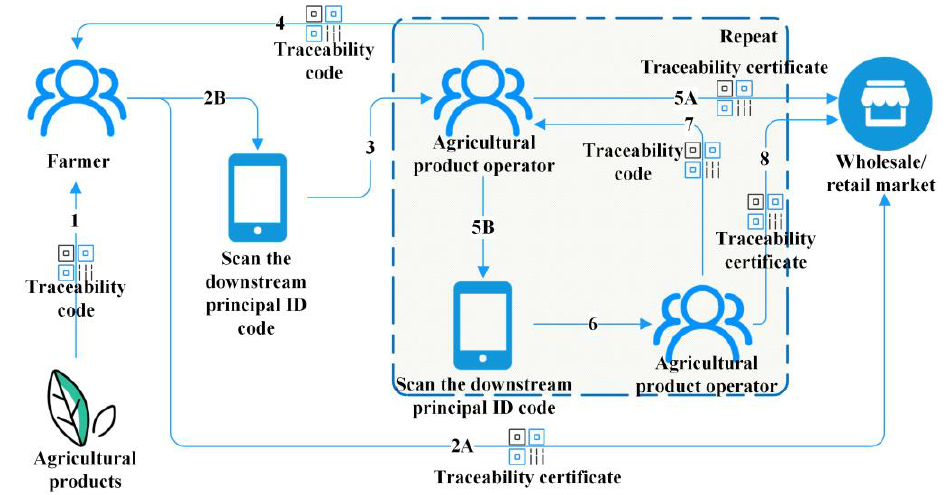
Figure 1. The flowchart of the traceability system.